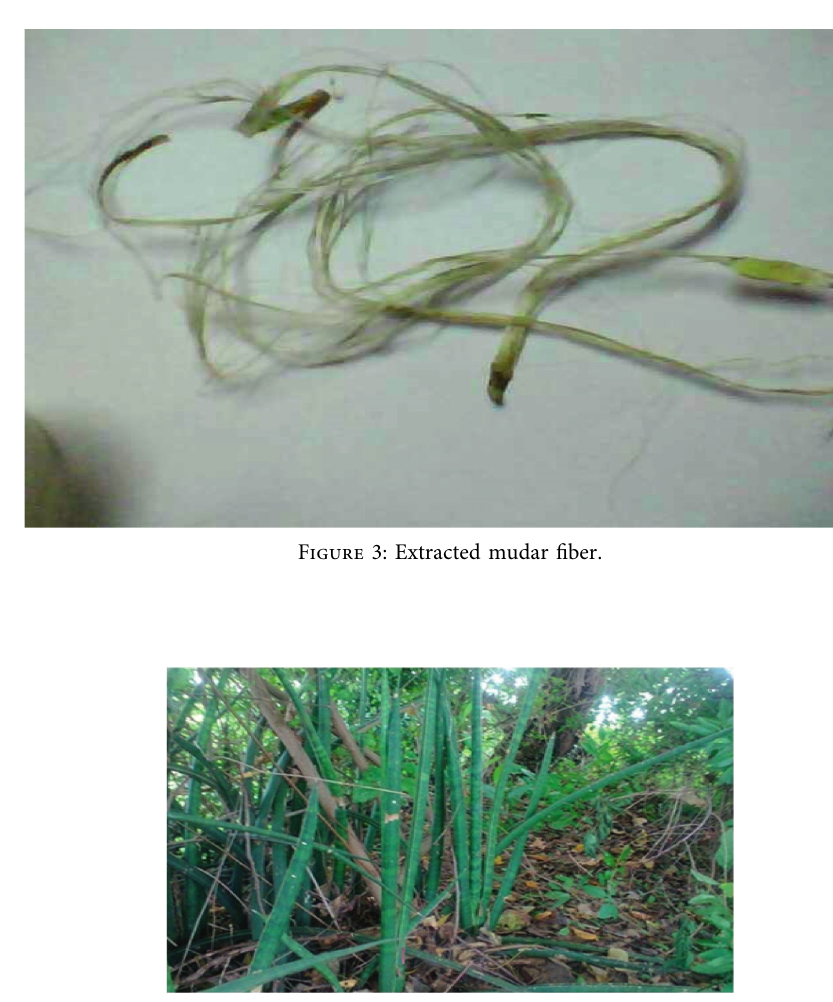
Figure 4: Sansevieria ehrenbergii .